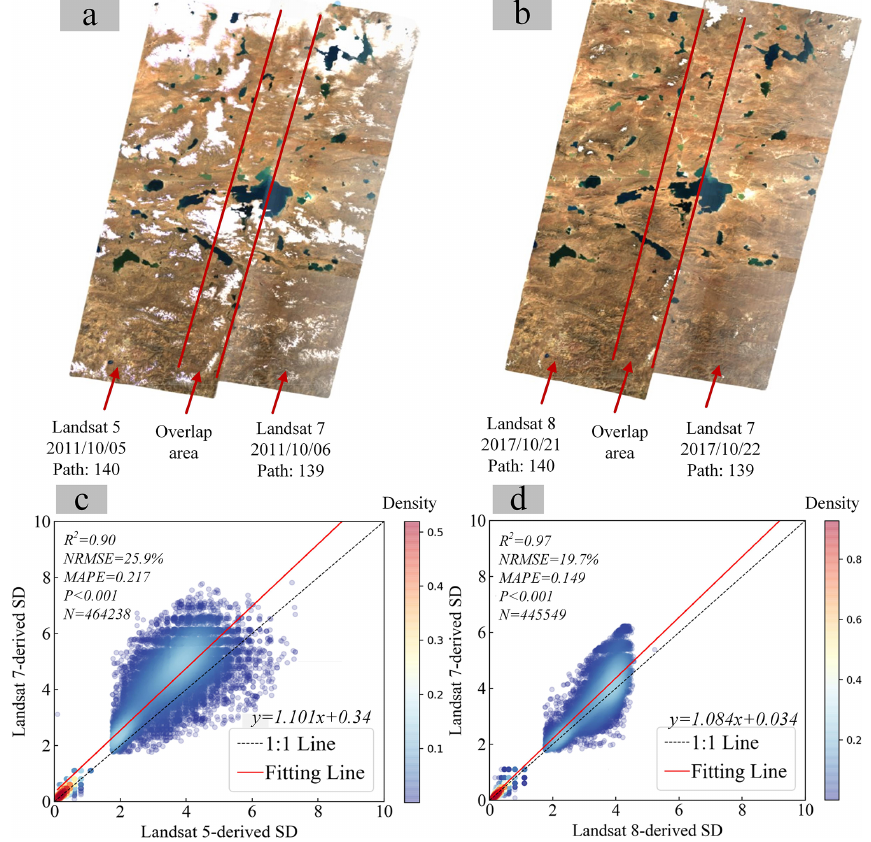
Figure 12. Overlapping regions of Landsat 5 and 7 data, (a) Landsat 8 and 7 data (b) , lake SD comparison for the Landsat 7 vs. 5 data, and (c) the Landsat 7 vs. 8 data (d) for the lakes from the overlap. The Landsat imagery for (a) and (b) come from the United States Geological Survey (https://earthexplorer.usgs.gov/, last access: 10 September 2021).